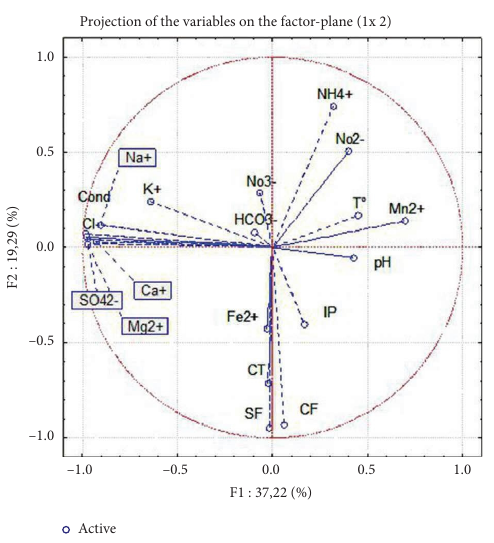
Figure 3: Distribution of parameters on the factorial plane ( F 1- F 2)